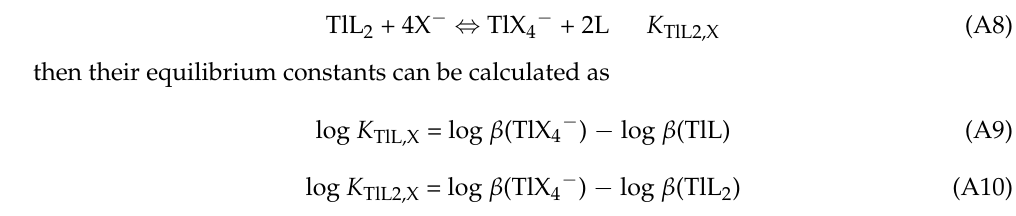
then their equilibrium constants can be calculated as